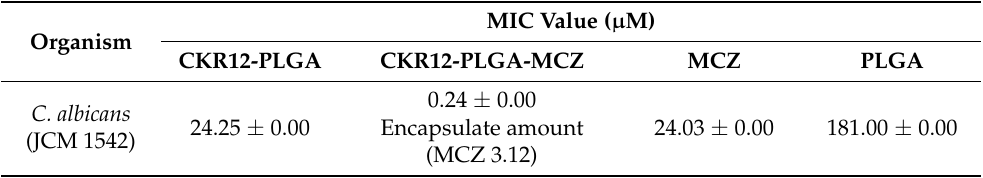
Table 1. Minimum inhibitory concentration (MIC) of MCZ, CKR12-PLGA, and CKR12 PLGA-MCZ against C. albicans . The MIC ( µ M) was determined as the average values of three experiments.